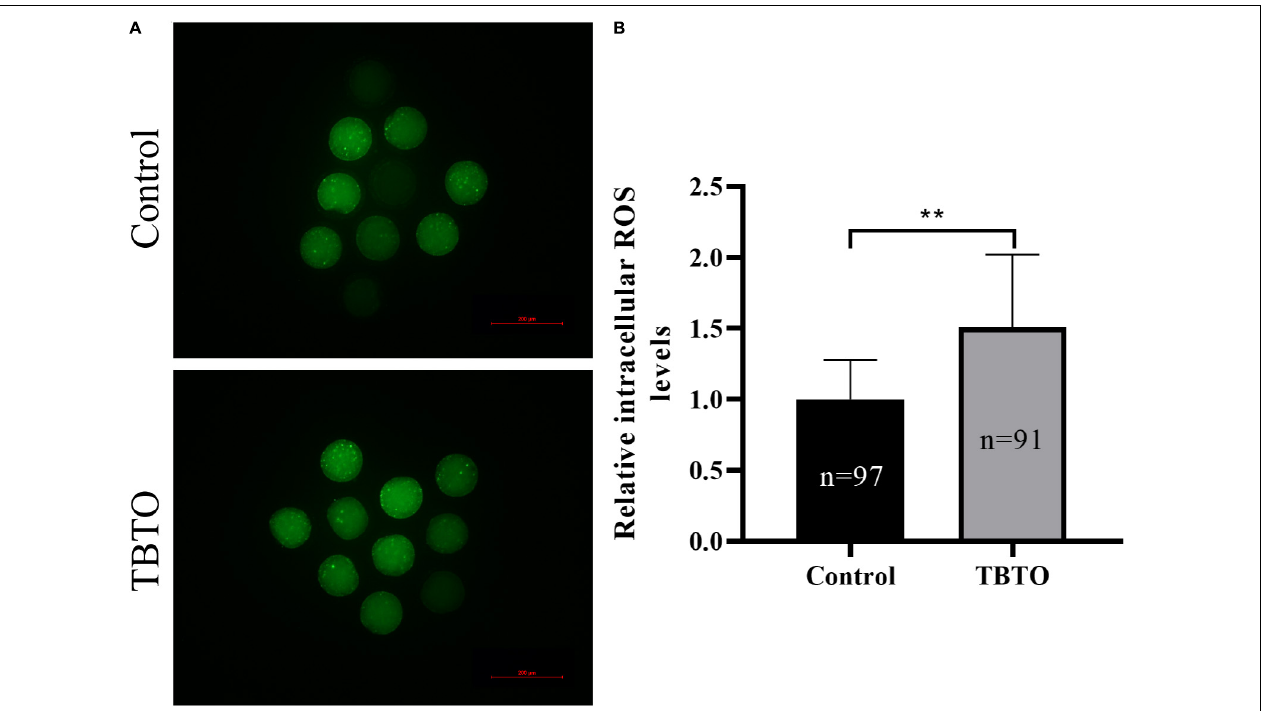
FIGURE 4 | Effects of TBTO exposure on intracellular ROS generation in porcine oocytes. (A) Representative fluorescence images showing intracellular ROS levels in porcine oocytes in the control and TBTO exposure group at the end of the IVM period. Scale bar = 200 µ m. (B) Quantification of relative intracellular ROS levels in porcine oocytes from the control and TBTO exposure group. The numbers of oocytes examined from the different groups are indicated by the bars. ∗∗ p < 0.01 compared to the